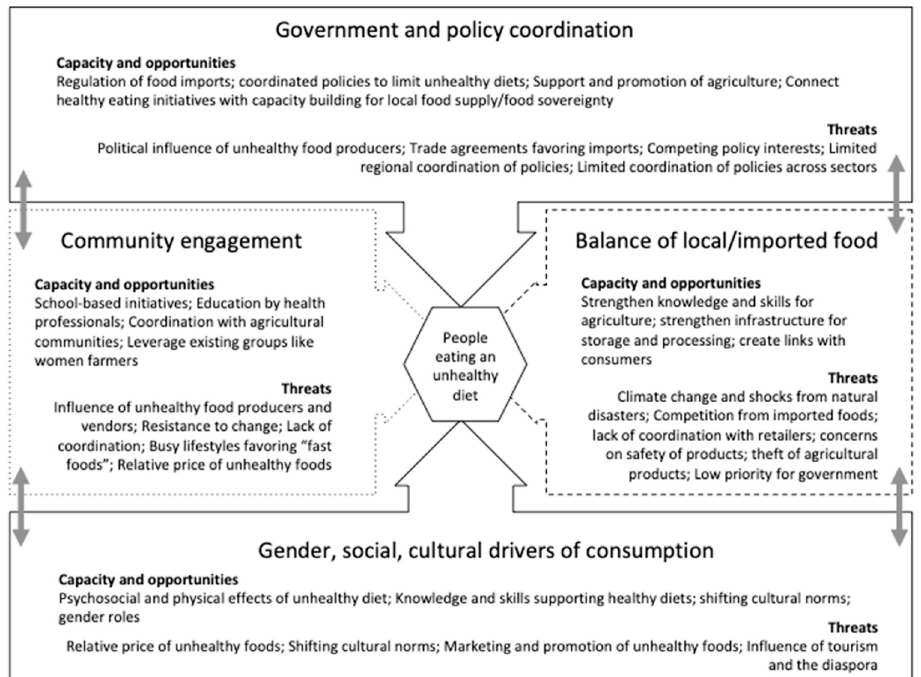
Figure 1. Overarching themes of drivers and places to intervene for reducing unhealthy